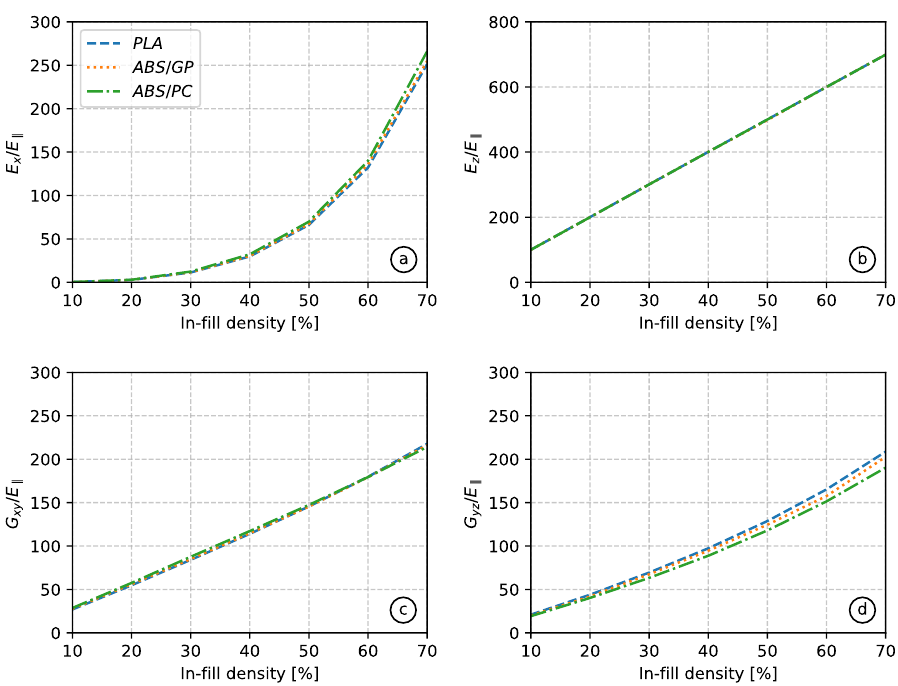
Figure 12. Non-dimensional relationships for the inner zone from all tested materials: Young’s modulus in direction X ( a ), Young’s modulus in direction Z ( b ), shear modulus in the XY plane ( c ), shear modulus in the YZ plane ( d